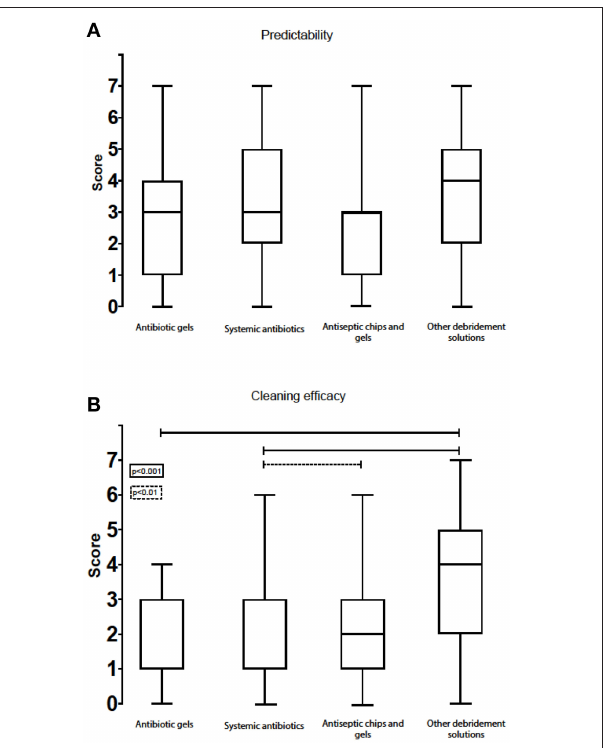
FIGURE 6 | Box-plot with score of predictability (A) and cleaning efficacy (B) for the various chemical